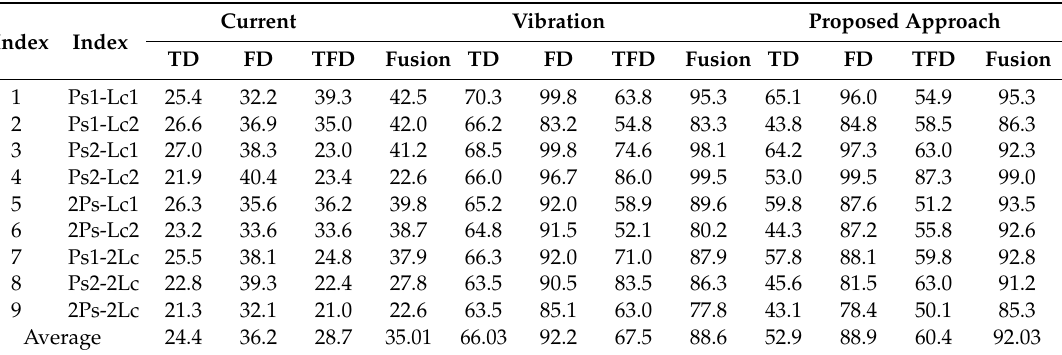
Table 3. Resulting diagnostic